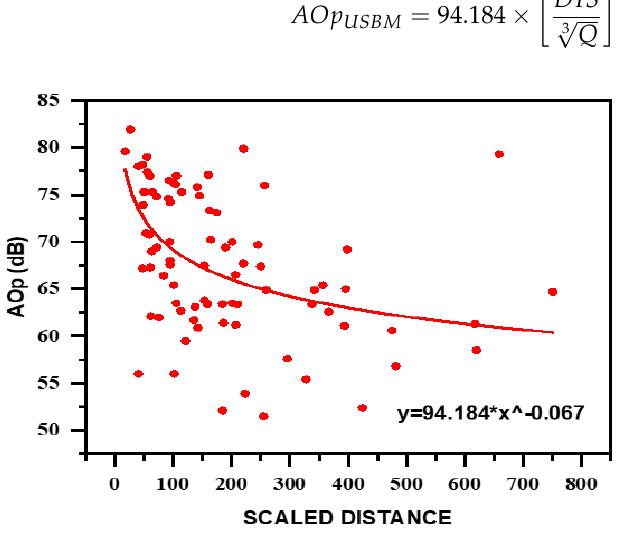
Figure 7. Developed USBM empirical predictor of AOp.